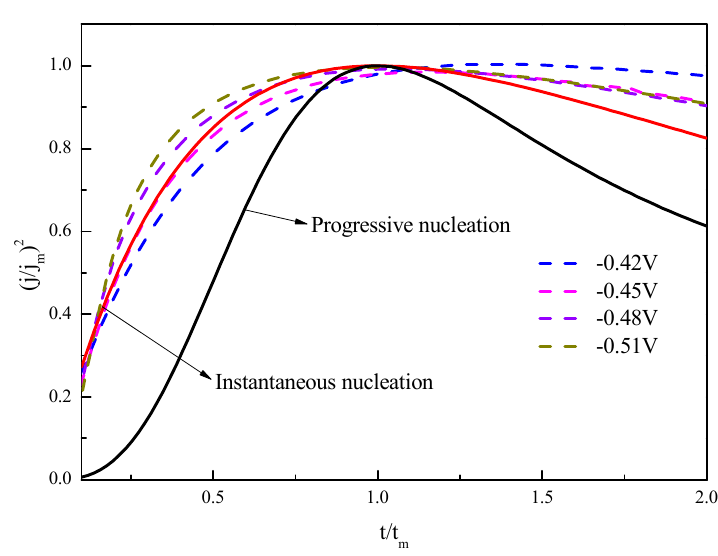
Figure 5. Comparison of the experimental data derived from the current density–time transients with the theoretical models for progressive and instantaneous nucleations.